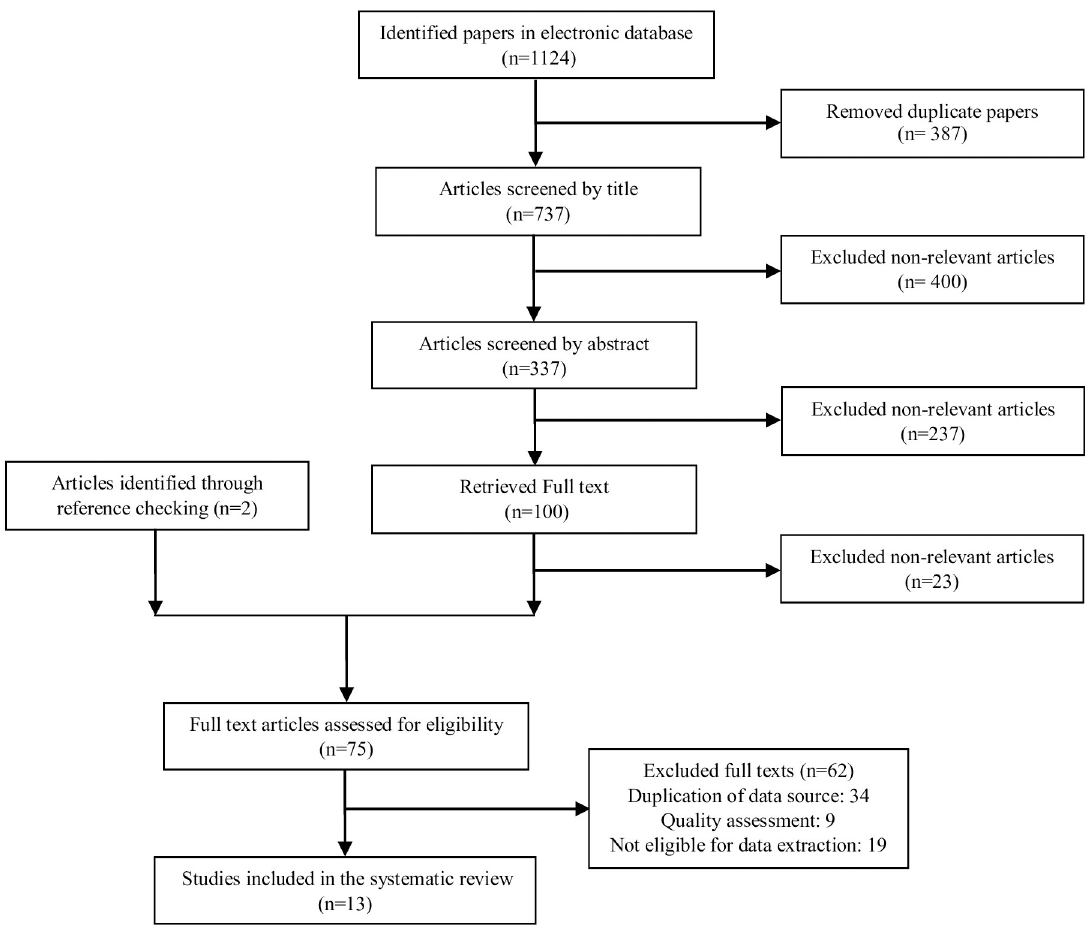
Fig 1. Papers search and review flowchart for selection of primary